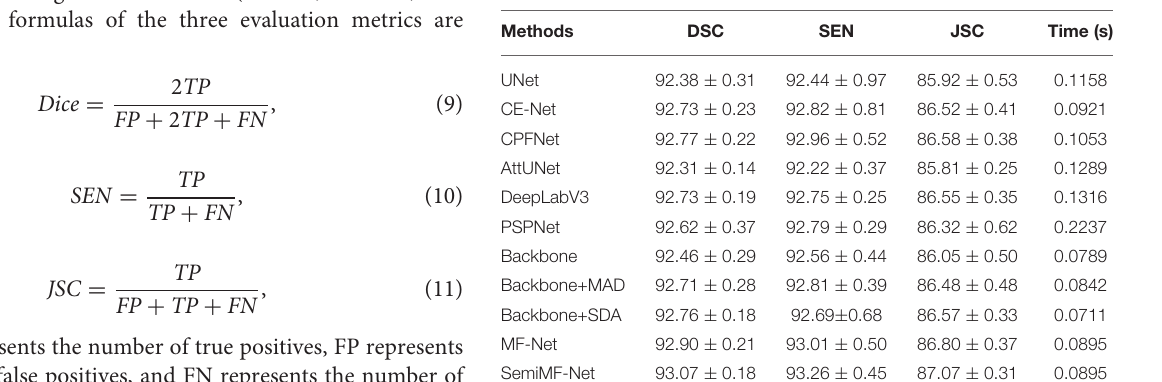
TABLE 2 | The result of comparison experiments and ablation studies (mean ±